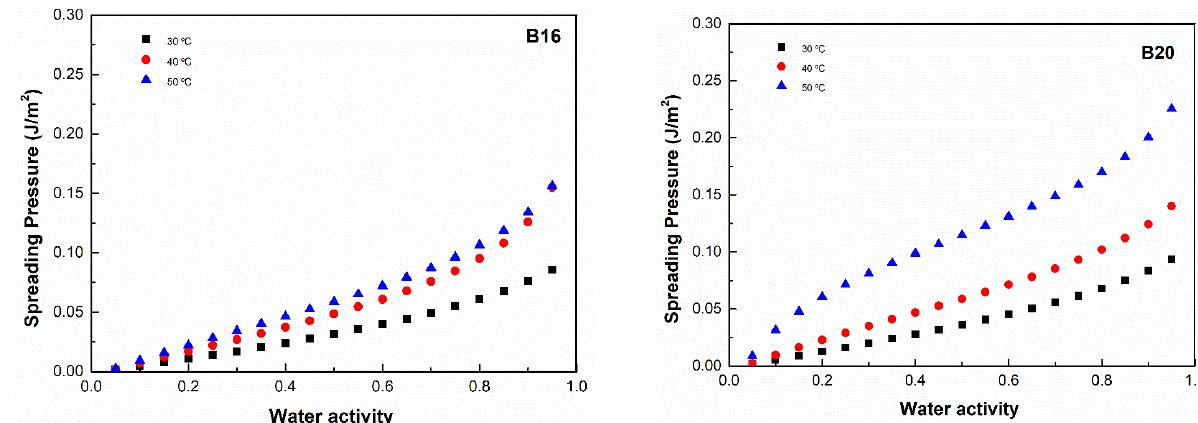
Figure 6. Spreading pressure adsorption isotherms for B16 and B20 at 30, 40, and 50 °C.